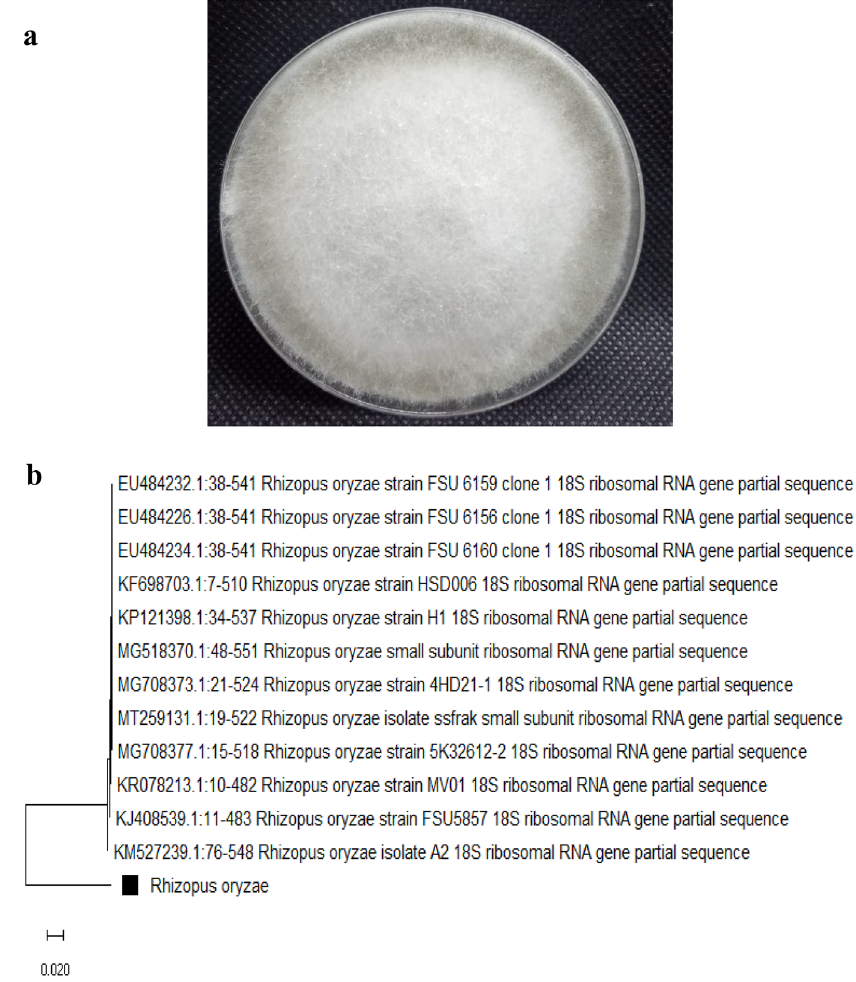
Figure 1. Plate of the pure isolate growth morphology ( a ) as well as the identification tree of molecular identification ( b ). Rhizopus